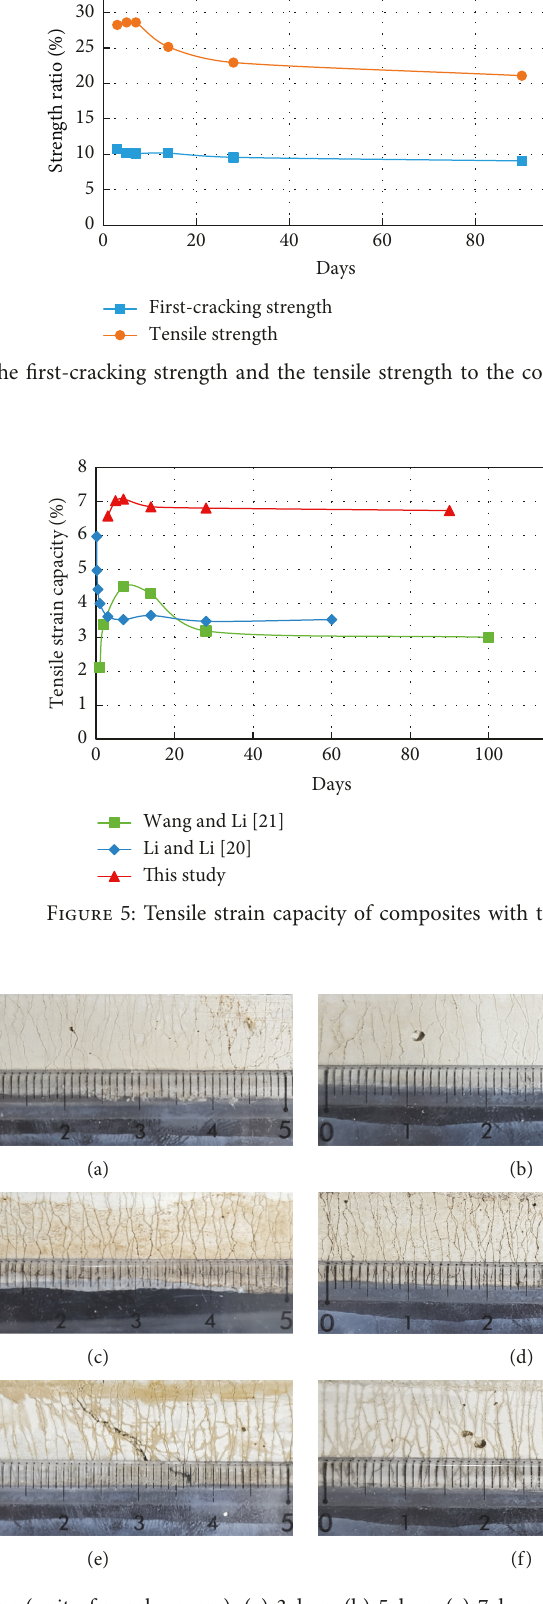
Figure 6: Cracking patterns (unit of numbers: cm): (a) 3days; (b) 5days; (c) 7days; (d) 14days; (e) 28days; (f)